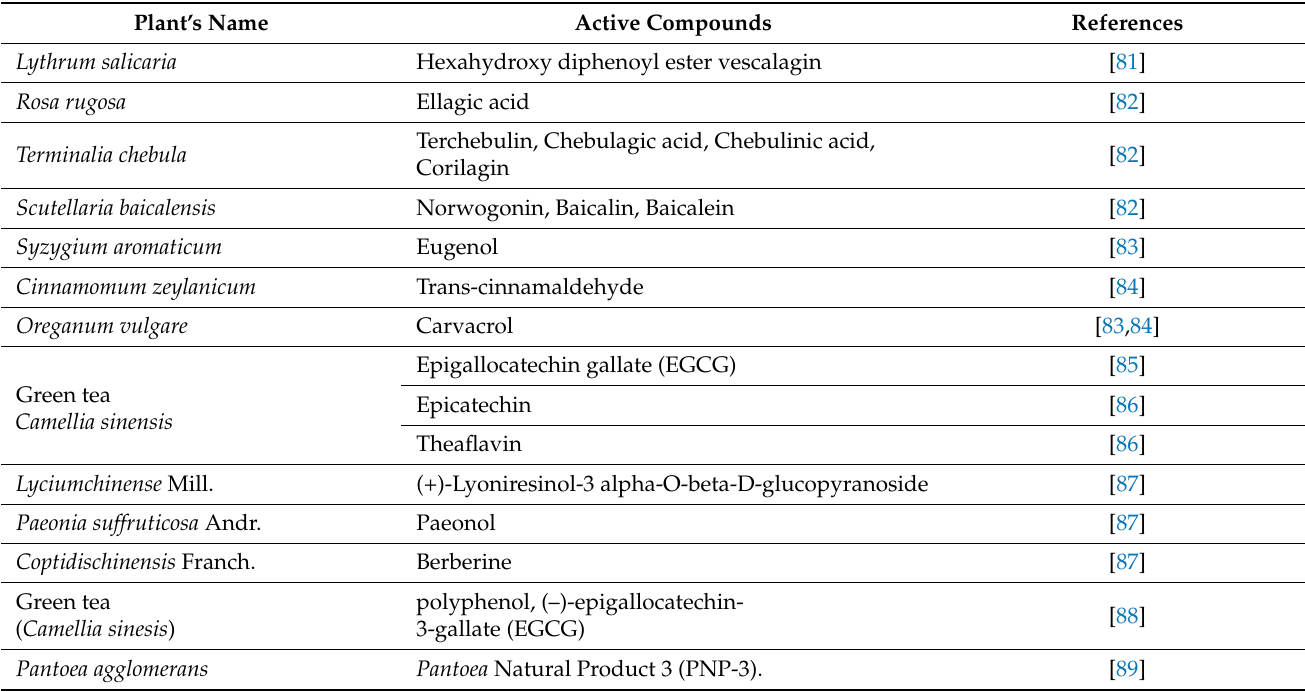
Table 2. List of natural products used against A. baumannii